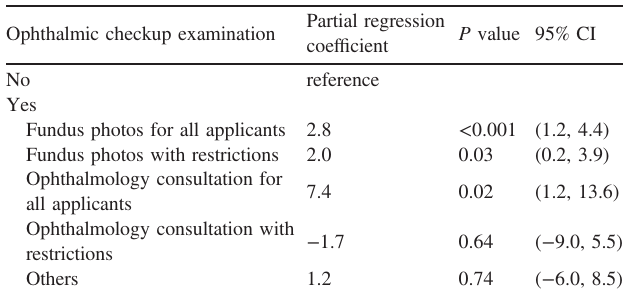
Table 2. The speci fi c health checkup participation rate among municipalities categorized by the population size with or without ophthalmic checkups